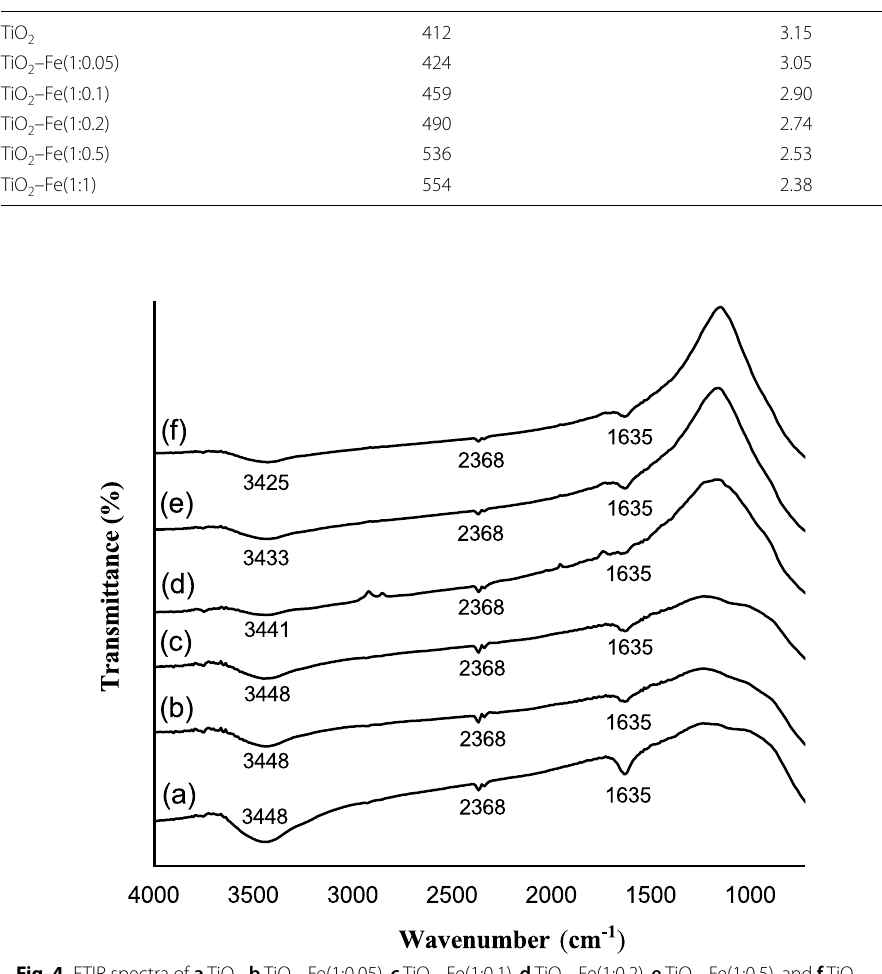
Table 1 Band gap (Eg) energy values of the TiO Photocatalyst